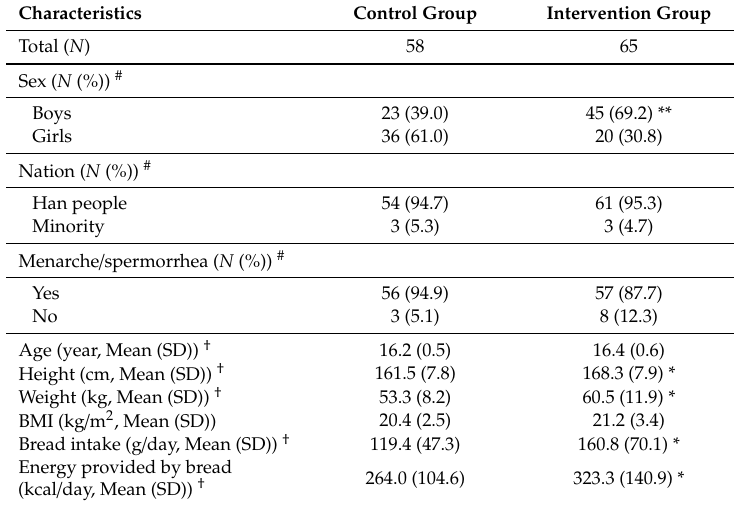
Table 2. Characteristics of participants at